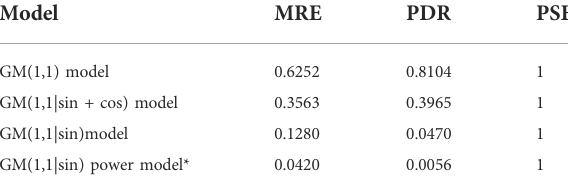
The bold values represent that the results of the model of our paper compared with other models. The results of our paper are the best.